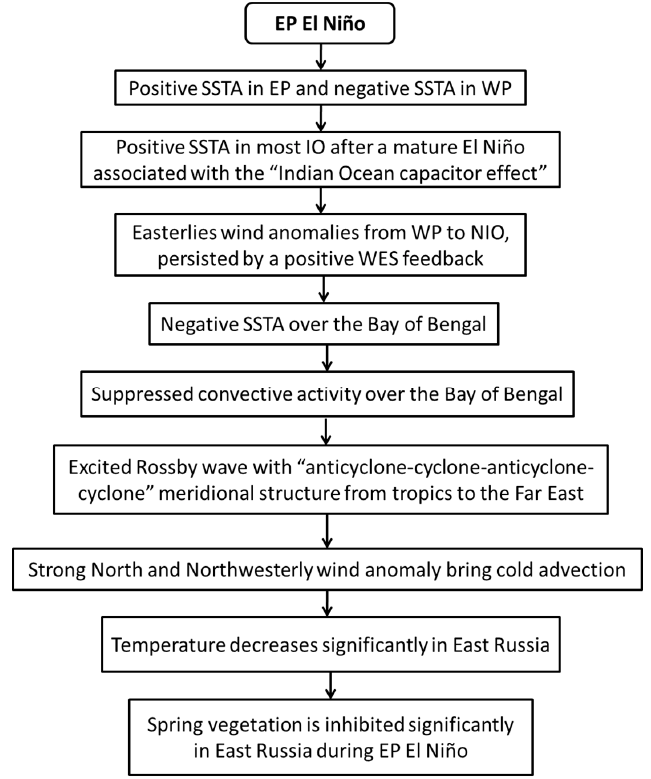
Figure 11. Schematic diagram of possible physical processes for the teleconnection relationship between EP El Niño and spring ERNDVI.